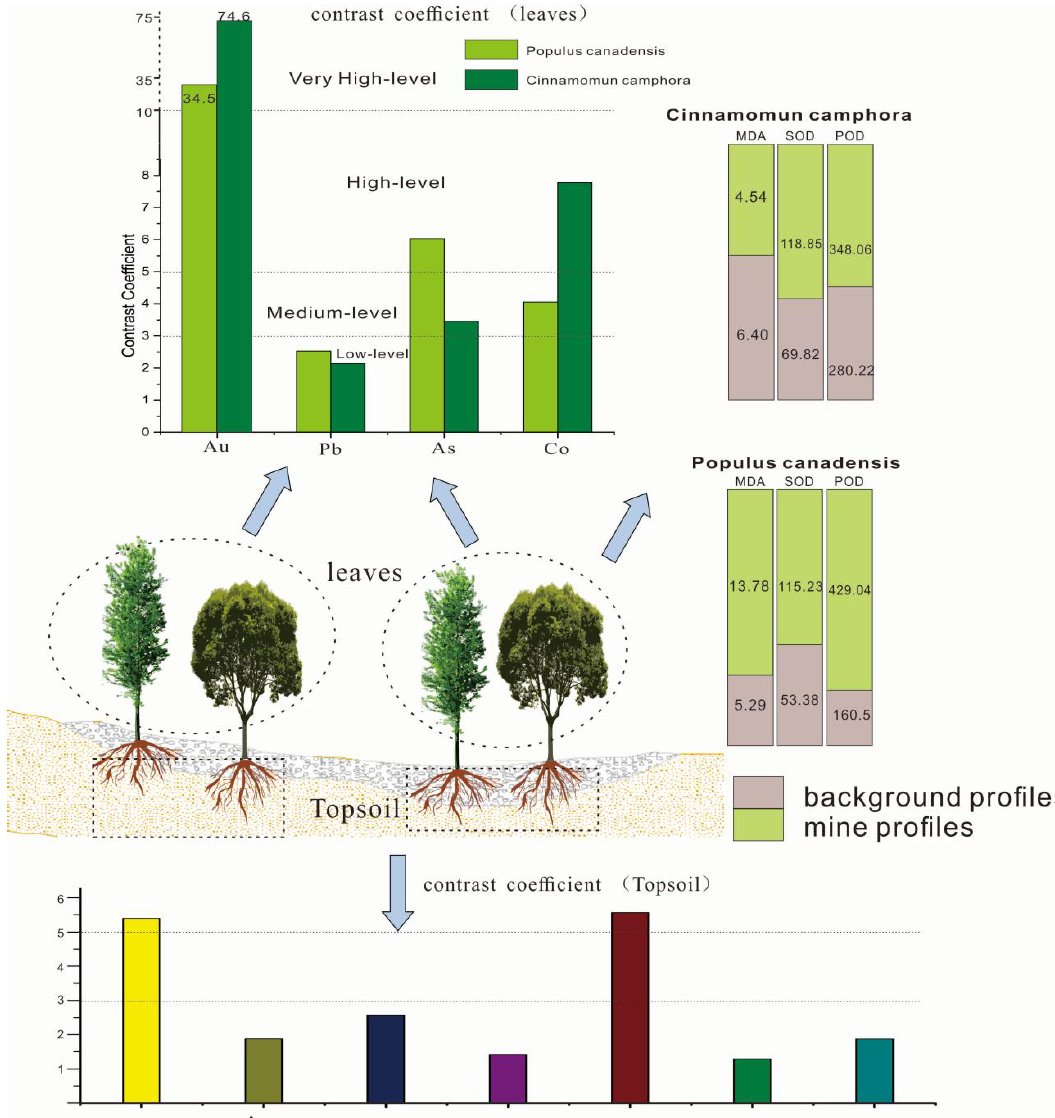
Figure 5. The contrast coefficient, MDA content, and enzymatic activity of plants in mine and background profiles. Table 5. The enzyme content of dominant plants.